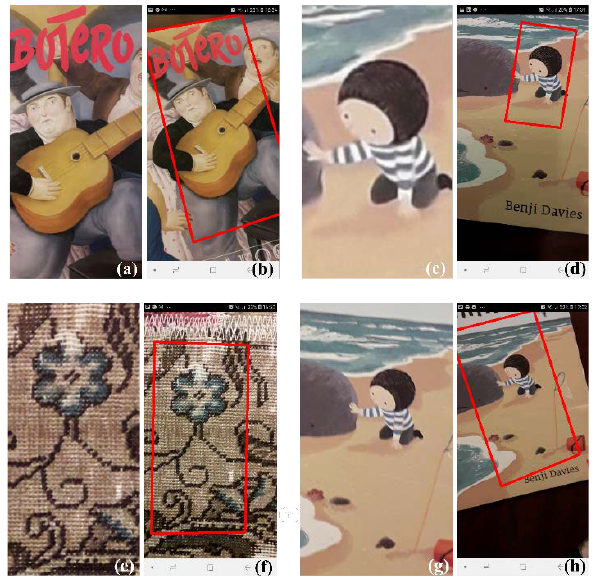
Figure 4 . Recognition of four different pattern objects; (a), (c), (e), (g): pattern images captured by the user; (b), (d), (f), (h): pattern recognition performed by the application.